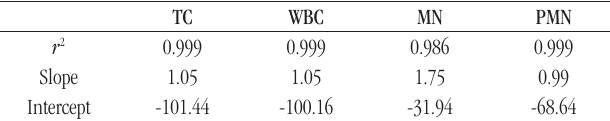
taBLE 1 − Results of linearity of XE-5000 for TC, WBC, MN and PMN